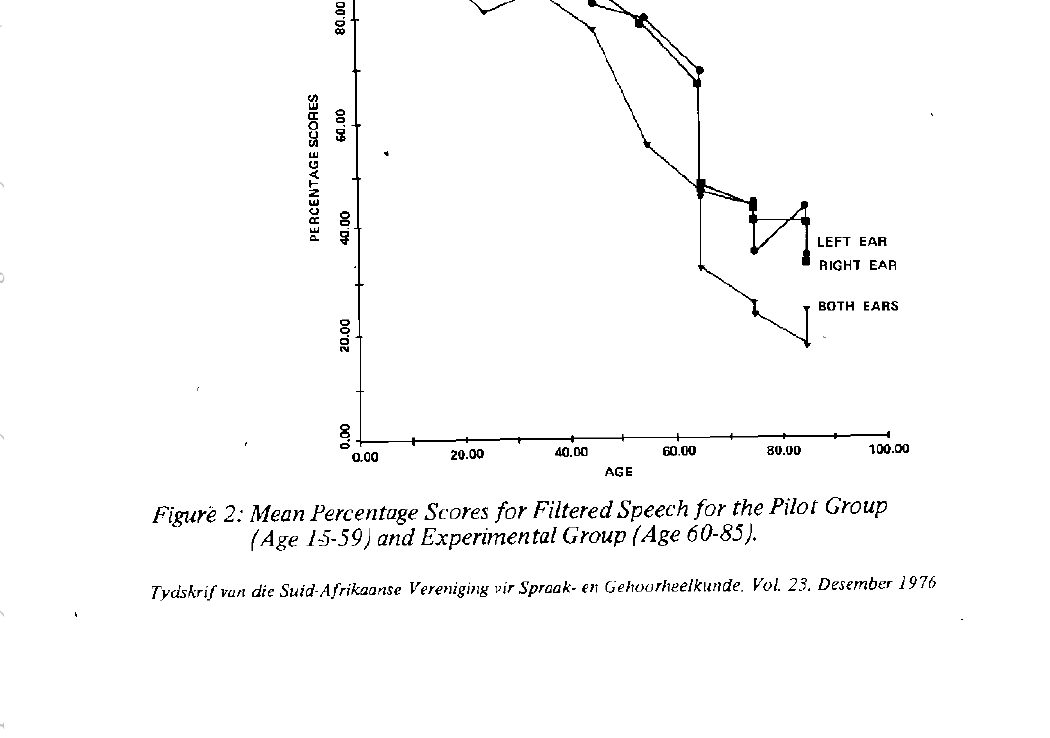
Figure 1: Mean Percentage Scores for Filtered Speech for the Pilot Group (Age 15-59) and Control Group (Age 60-85).